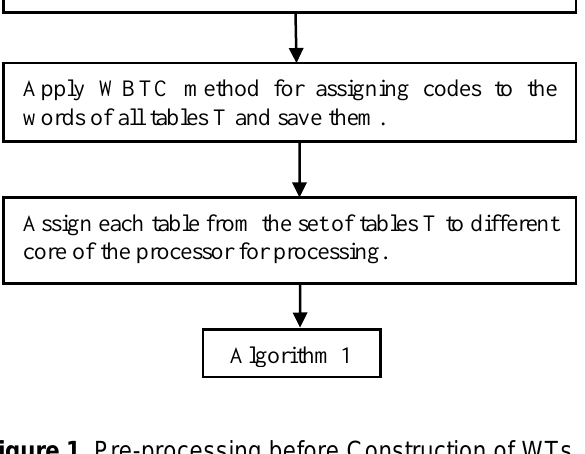
Figure 1. Pre-processing before Construction of WTs parallelly